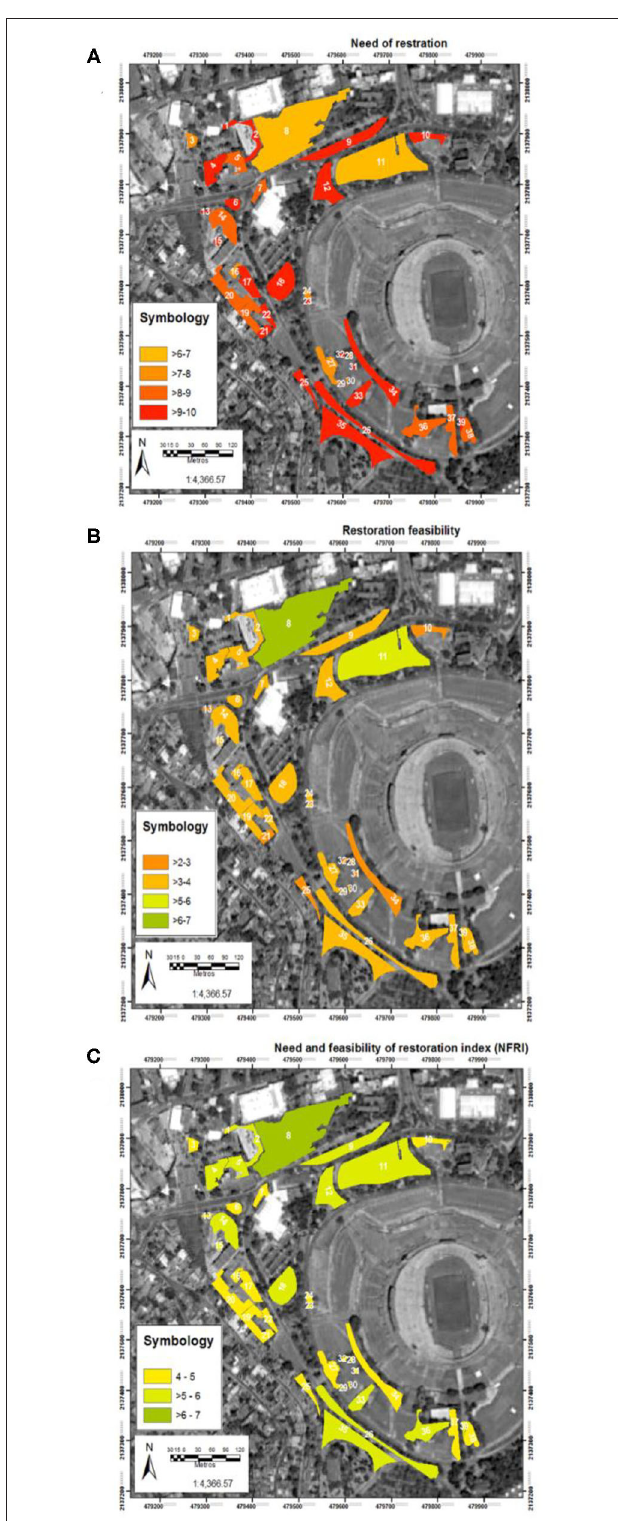
FIGURE 3 | Maps showing the main results of the multicriteria analysis for the study sites around the University Olympic Stadium. Need of restoration (A) ; Restoration feasibility (B) ; Need and feasibility of restoration index (NFRI) (C)